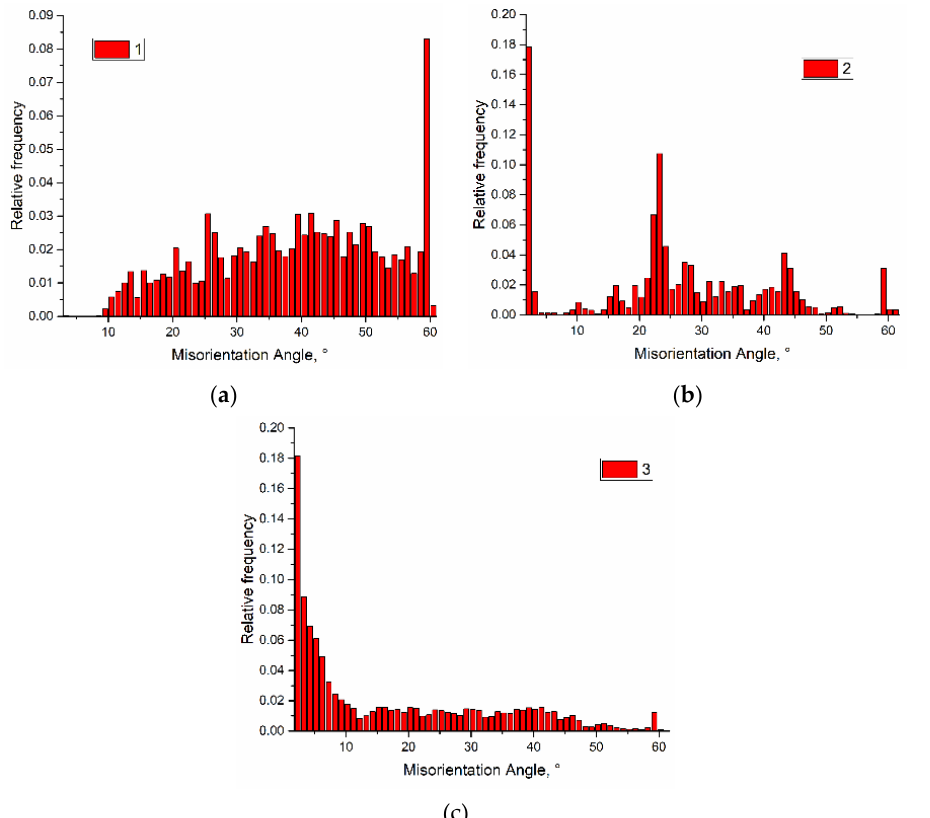
Figure 10. Misorientation angle distribution of grain boundaries for samples printed at 0.21 kJ/mm ( a ), 0.255 kJ/mm ( b ) and 0.3 kJ/mm high ( c ) heat input.